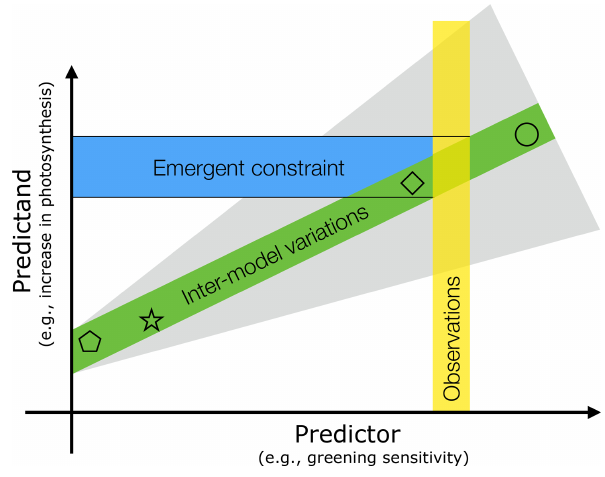
Figure 1. Schematic depiction of the emergent constraint (EC) method and factors affecting the uncertainty of the constrained es- timate. The predictor ( x axis) is change in the annual maximum of green leaf area index (LAI max ) due to unit forcing (CO 2 increase and associated climatic changes) during a representative historical period. It is termed greening sensitivity in this study. The predictand ( y axis) is projected change in gross primary productivity (GPP) in response to rising CO 2 concentration (e.g., for a doubling of the preindustrial level). Both the predictor and predictand refer to large area values: in this case, the entire northern high latitudes (NHLs). Inter-model variations (each symbol represents a model) in match- ing pairs of predictors and predictands result in a linear relationship between the two (green band); i.e., the ratio (predictand / predictor) is approximately constant across the model ensemble. The slope depends on forcing attributes (gray shading), such as its level (CO 2 concentration; Sect. 3.4), time rate of application (scenarios such as various RCPs; Sect. 3.4), and different effects (i.e., fertiliza- tion, radiative forcing; Sect. 3.5). The observed sensitivity (vertical yellow bar) is used to find the constrained estimate of the predic- tand (i.e., change in GPP). The ability to accurately estimate the predictor depends on the source of observational data (Sect. 3.1) and its spatial (Sect. 3.2) and temporal variability (Sect. 3.3). Ob- served (yellow bar) and modeled predictor values ( x coordinate of symbols) must be obtained from matching time periods, i.e., at the same level of historical forcing, to ensure comparability (Sect. 3.3 and 3.4). All these factors, together with the goodness of fit of inter- model variations (width of green shading), finally define the un- certainty of the derived constrained estimate (blue horizontal bar with black solid lines depicting the upper and lower bound of un-